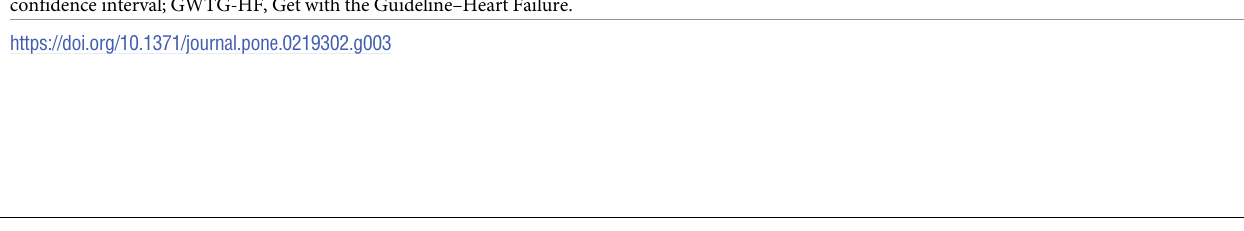
PLOS ONE | https://doi.org/10.1371/journal.pone.0219302 July 8, 2019 8 /